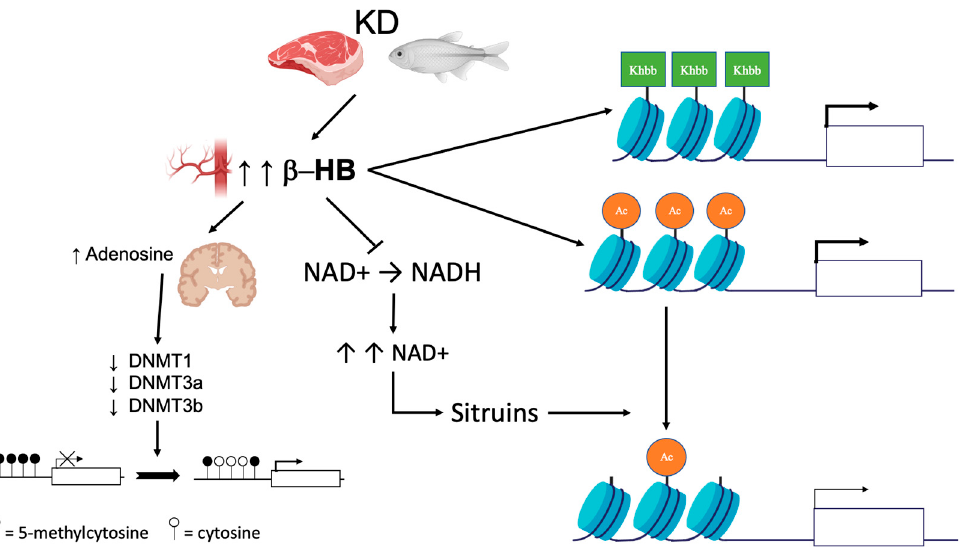
Figure 1. Epigenetic changes induced by KD. KD leads to an increase in circulating ketone bodies ( β -hydroxybutyrate [ β -HB]). In the brain, higher concentrations of β -HB have inhibitory effects on DNA methyltransferases (DNMT) via an increase in adenosine, which in turn leads to global DNA hypomethylation. Ketone bodies also act as epigenetic modifiers that determine covalent modifications at key histones such as lysine acetylation (Ac), methylation, and β -hydroxybutyrylation (Kbhb). Finally, β -HB is less efficient than glucose as a substrate for NADH production. The increase in the NAD + level promotes histone demethylation via the modulation of sirtuin activity.